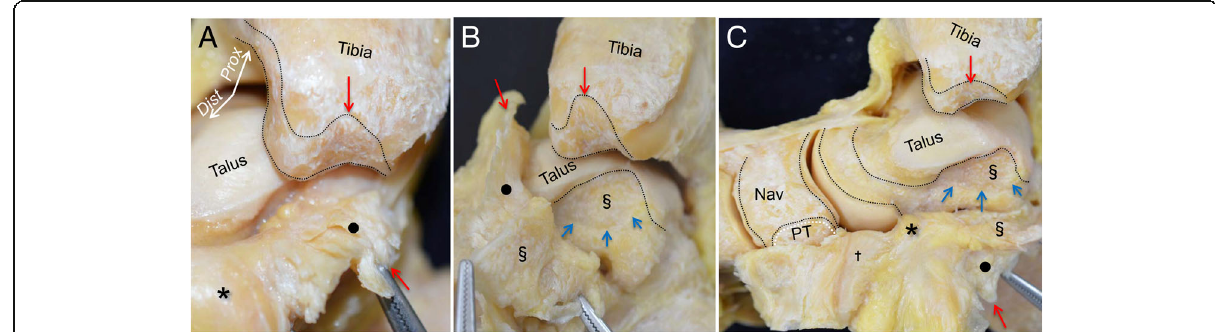
Fig. 3 Detailed observation of the joint capsule in the medial ankle. a The medial part of the capsule appeared fibrous ( black circle ). There is a clear qualitative difference between the anterior fatty tissue ( asterisk ) and the medial fibrous tissue. Red arrows indicate the corresponding bone and detached capsule. b The fibrous capsule occupied the space of the intercolliculus groove like a mortise joint. The corresponding side of the fibrous capsule (section mark in Fig. 3b) widely attached to the depressed area of the medial side of the talus (blue arrows), which formed an ellipse. c The posteromedial fibrous capsule extended distally, and changed to cartilaginous tissue ( dagger ). The cartilaginous tissue covered the talus head, and attached to the proximal portion of the PT tendon insertion ( white dotted line ). Similar marks represent the attachments of the capsule and corresponding parts of the capsule. Prox, proximal; Dist, distal; Nav , navicular; PT , insertion of the posterior tibialis tendon